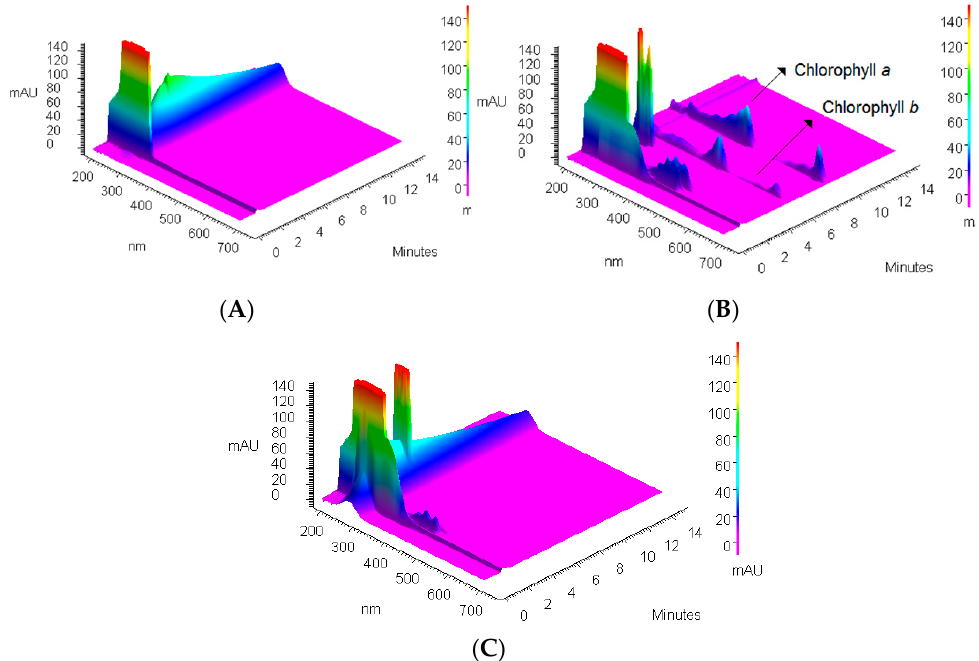
Figure 5. 3D chromatograms of ( A ) 20 µL of blank (acetone-water 2:1 v / v ), ( B ) 20 µL of spinach extract solution (0.5 mL, 5 mL acetone, 1 mL deionized water), ( C ) 20 µL of supernatant after PVC extraction (0.5 mL extract, 1.5 mL acetone, 1 mL water/0.60254 g Table 2. The removal of chlorophyll-a from a solution containing 0.5 mL of spinach leaf extract, 1.5 mL of acetone, and 1 mL of deionized water by the use of different masses of PVC sorbent in the batch adsorption experiments.